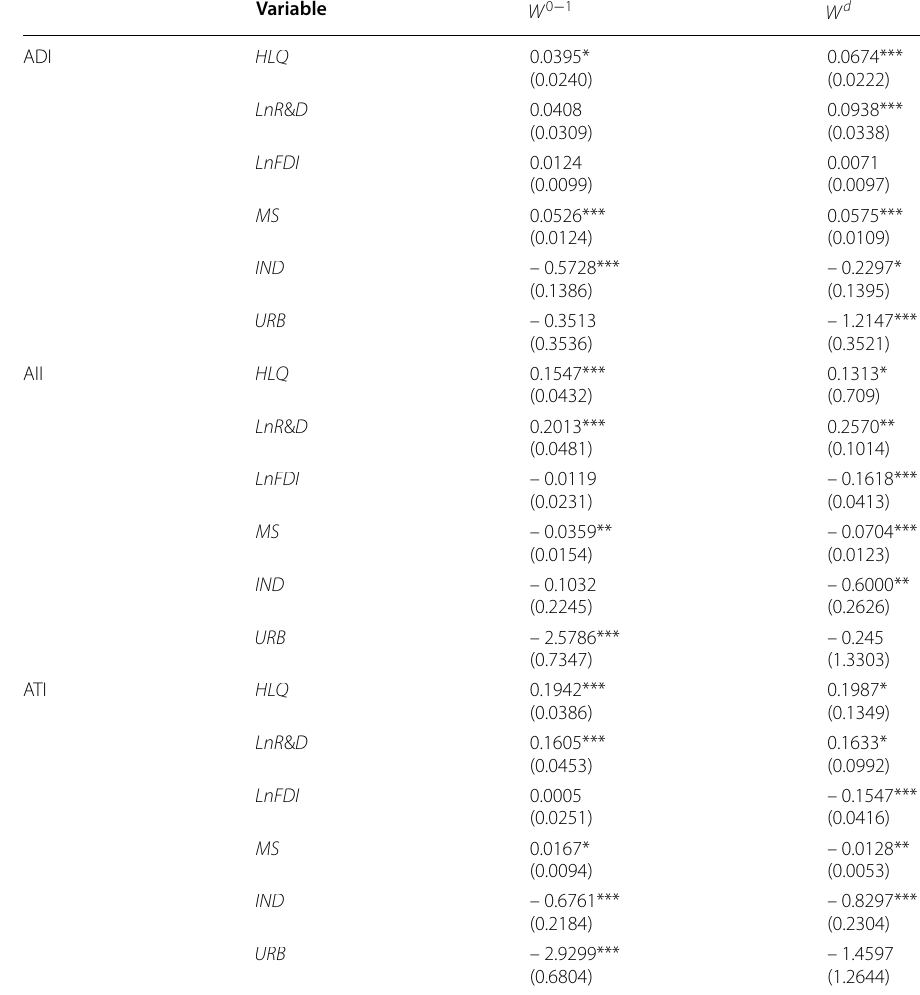
Table 5 Test results of direct effect, indirect effect and total effect